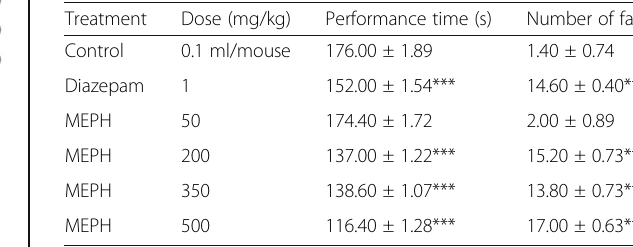
Table 4 The effect of MEPH on rota-rod test in